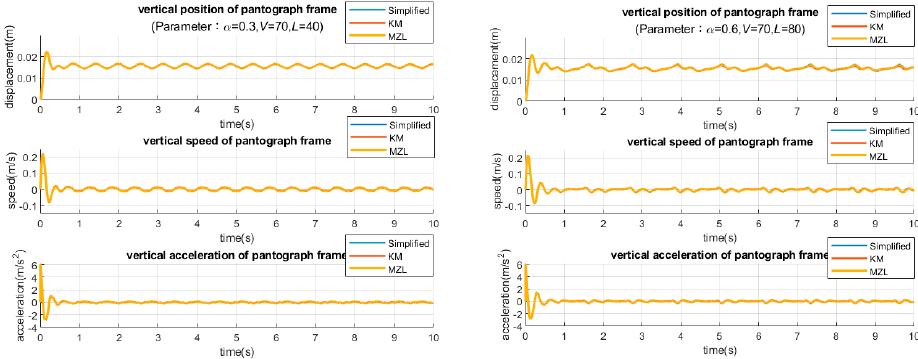
Figure 11. The resulting vertical position, velocity, and acceleration of the pantograph frame.